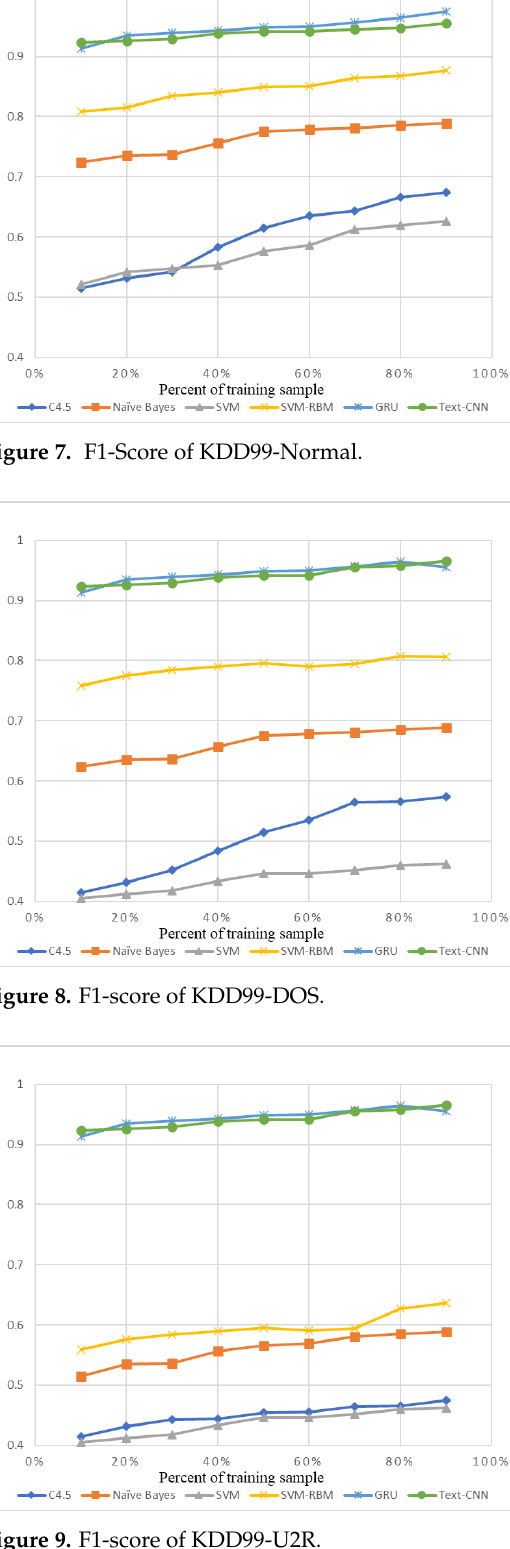
Figure 9. F1-score of